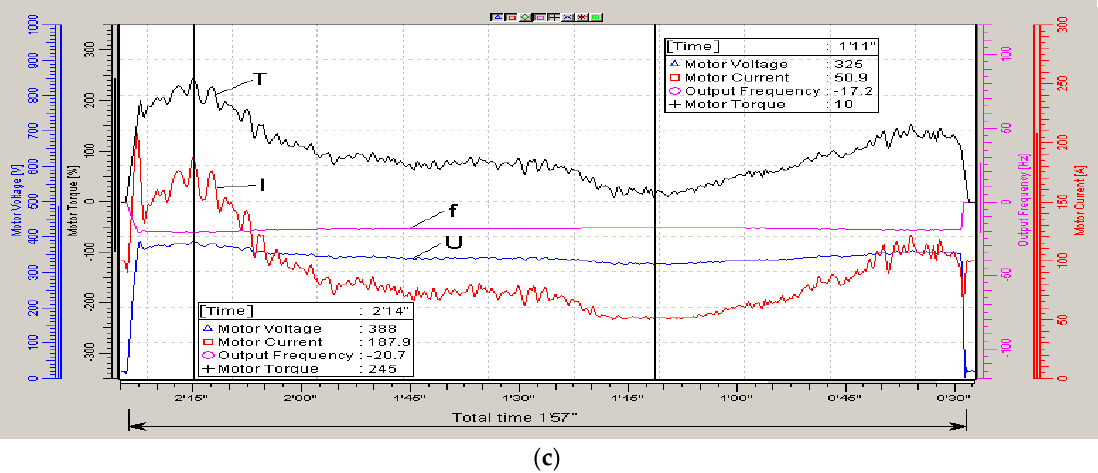
Figure 3. Diagrams of movement along track 1 ( a ) Medium speed with parameters U = 400 V, f = 25 Hz and U/f = 16 Fl ( b ) Medium speed with parameters U = 468 V, f = 25 Hz and U/f = 18.7 Fl ( c ) Low speed with parameters U = 318 V, f = 17 Hz and U/f = 18.7 Fl.